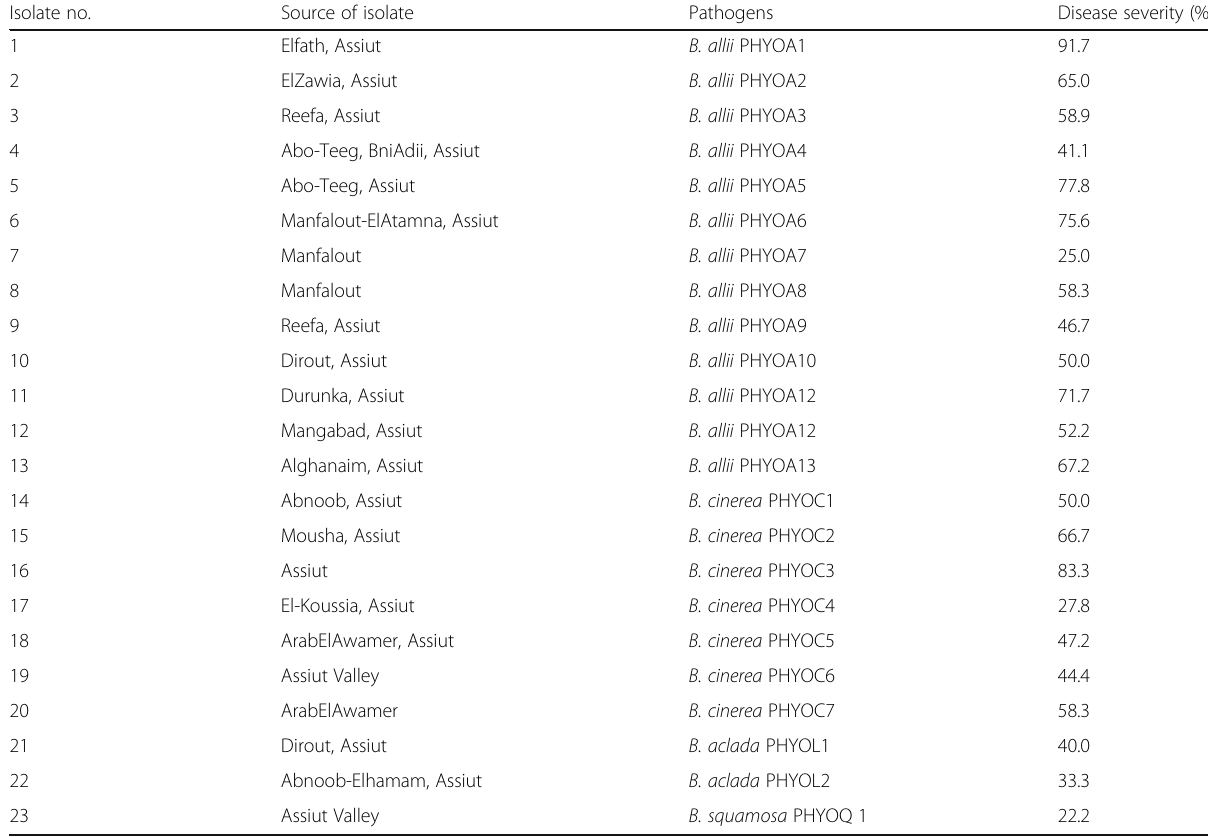
Table 2 Pathogenic capabilities of Botrytis spp . isolates on onion cultivar Giza 6 under open greenhouse conditions Isolate